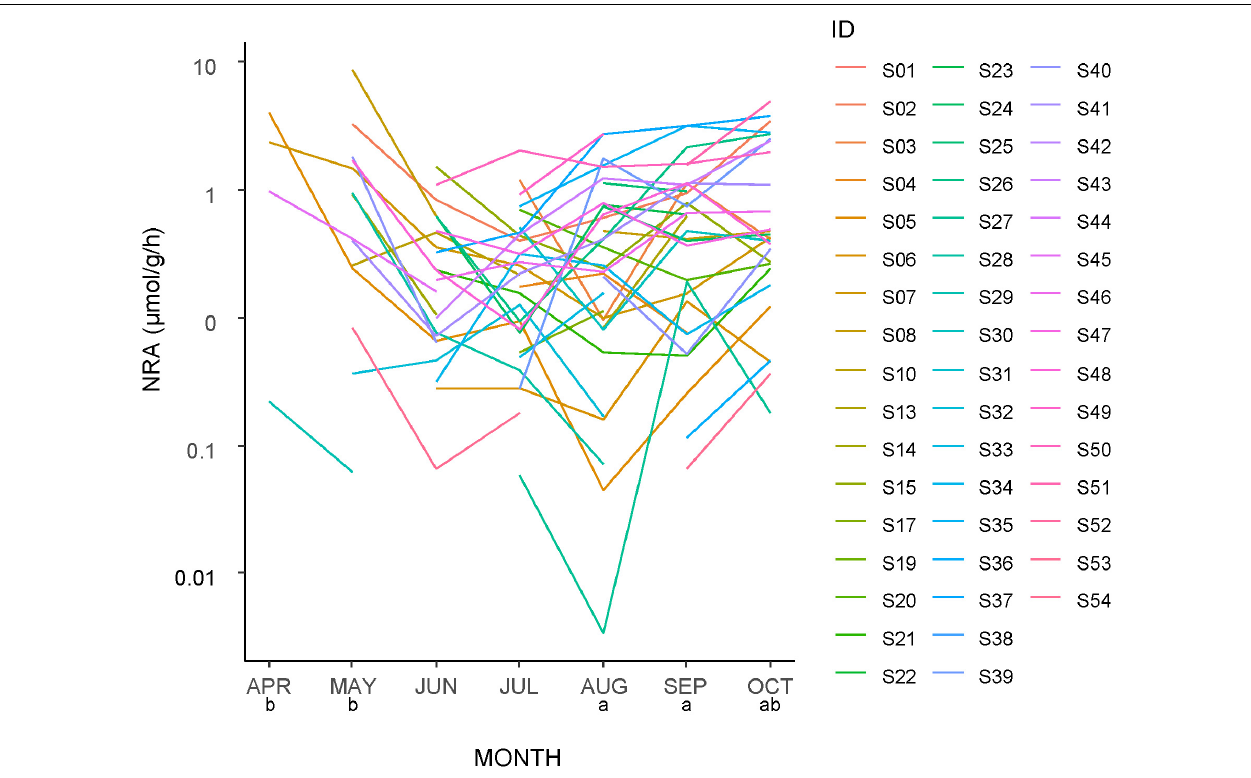
FIGURE 4 | Seasonal changes in the nitrate reductase activity (NRA) of leaves of each plant taxa in a logarithmic scale. The same letters below the month labels indicate no significant difference in the NRA among the months by a Tukey HSD multiple comparison following a generalized linear mixed model with SPECIES as a random effect (Gamma error structure and a log link function). See Supplementary Table S1 for taxa ID.